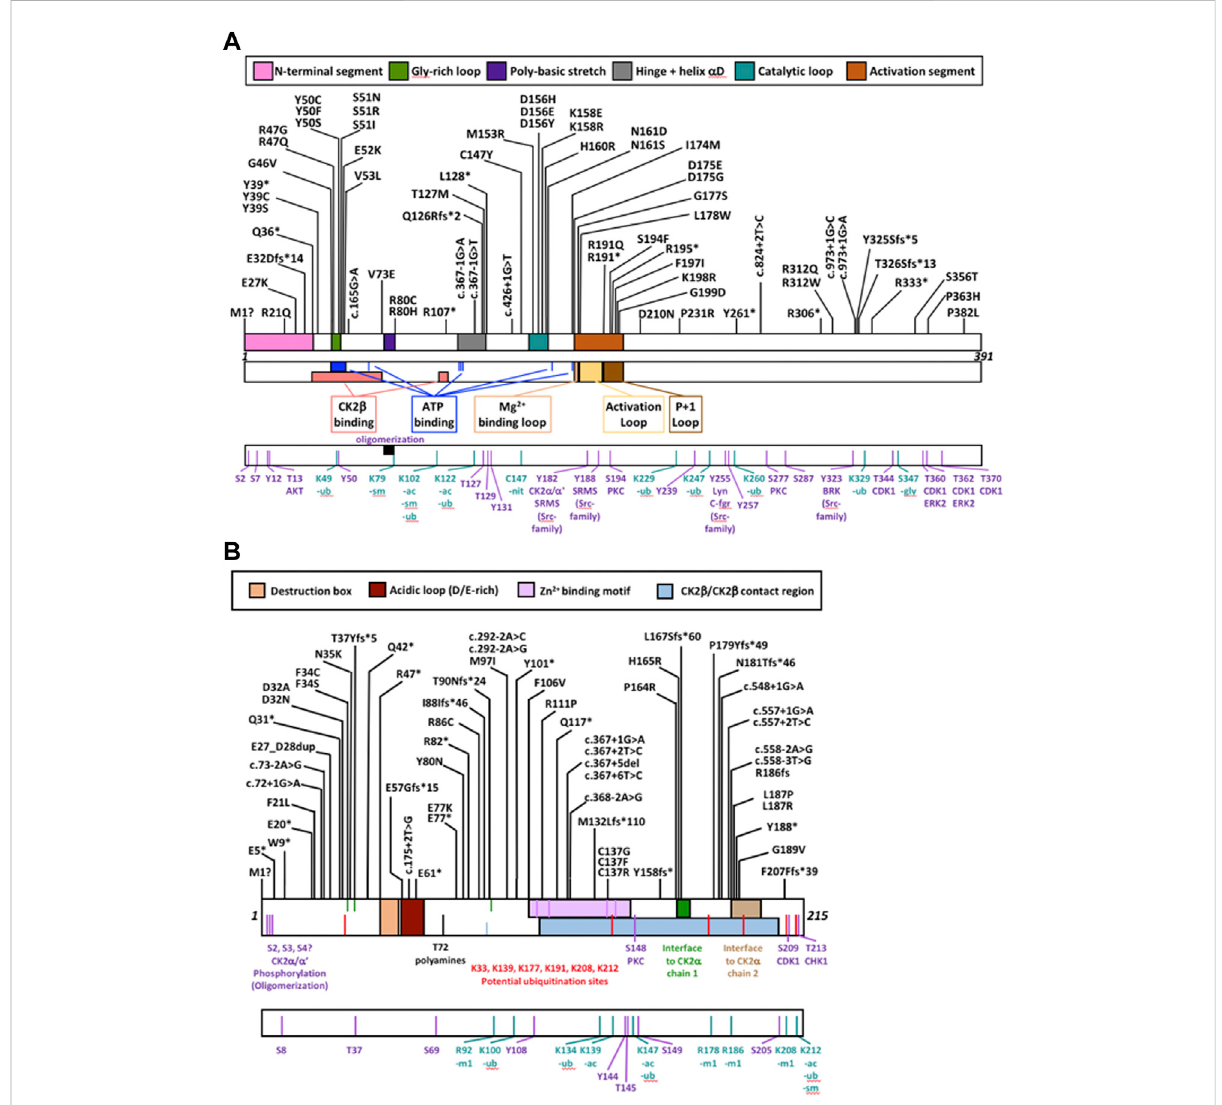
FIGURE 2 Protein diagram of CK2 α and CK2 β including the location of mutations to date. CK2 α (A) and CK2 β (B) mutants (nonsense, missense, start site variants, frameshift and splice) are represented on a diagram of the primary structure of the proteins. The diagrams include distinct structural and functionaldomains,andputativefunctionalresiduesforeachprotein.ForCK2 β ,theacidicloopdomainhasalsofunctionaspseudosubstrate,andfor oligomerization,polyaminebindingandpolybasicpeptidebinding.ThefourCys(residues109,114,137,140)keyforzincbindingarehighlighted in the Zn 2+ binding motif. Ac, acetylation; gly, glycosylation; m1, monomethylation; nit, nitrosylation; sm,